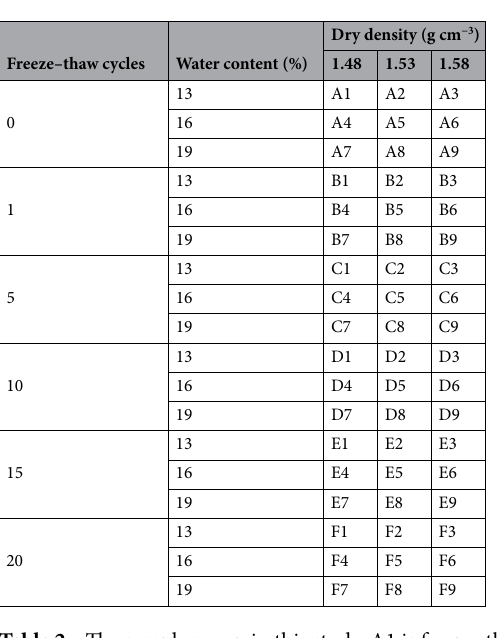
Table 2. The sample group in this study. A1 is freeze–thaw cycle 0 times, water content 13%, dry density 1.48 g cm −3 .